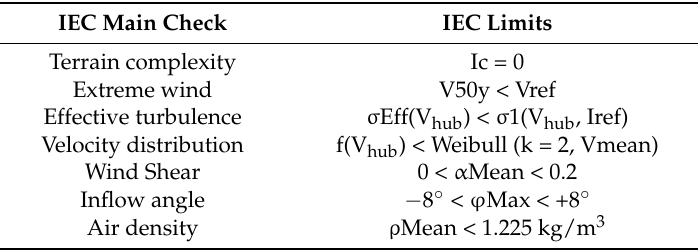
Table 3. Main IEC checks for site conditions and